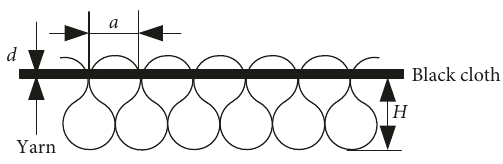
Figure 1: Schematic diagram of pile